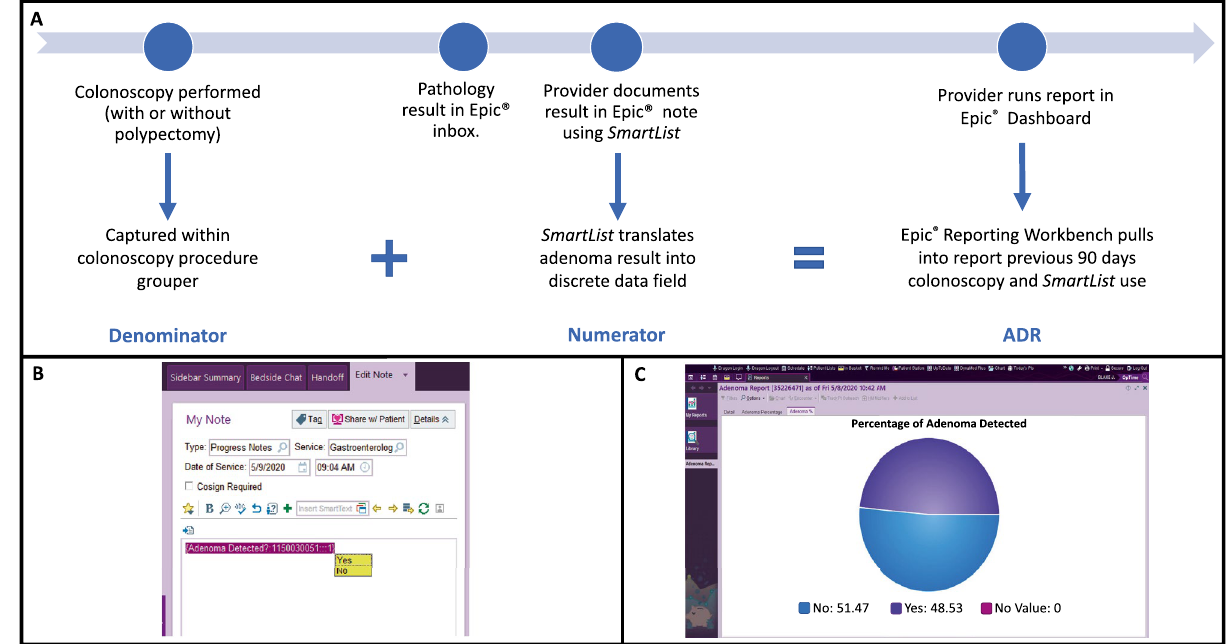
Figure 1. ( A ) Workflow timeline for utilizing the SmartList tool. When the report is run, all colonoscopies from the previous 90 days are included and linked to instances of SmartList use in the patient’s chart to calculate the tADR in the report. ( B ) The SmartList as displayed in a simple note. ( C ) The pie-chart display of the Reporting Workbench results representing the tADR. This figure was constructed from a screenshot from Epic Clinical Software, Version May 2021 (https:// www. epic. com/ softw